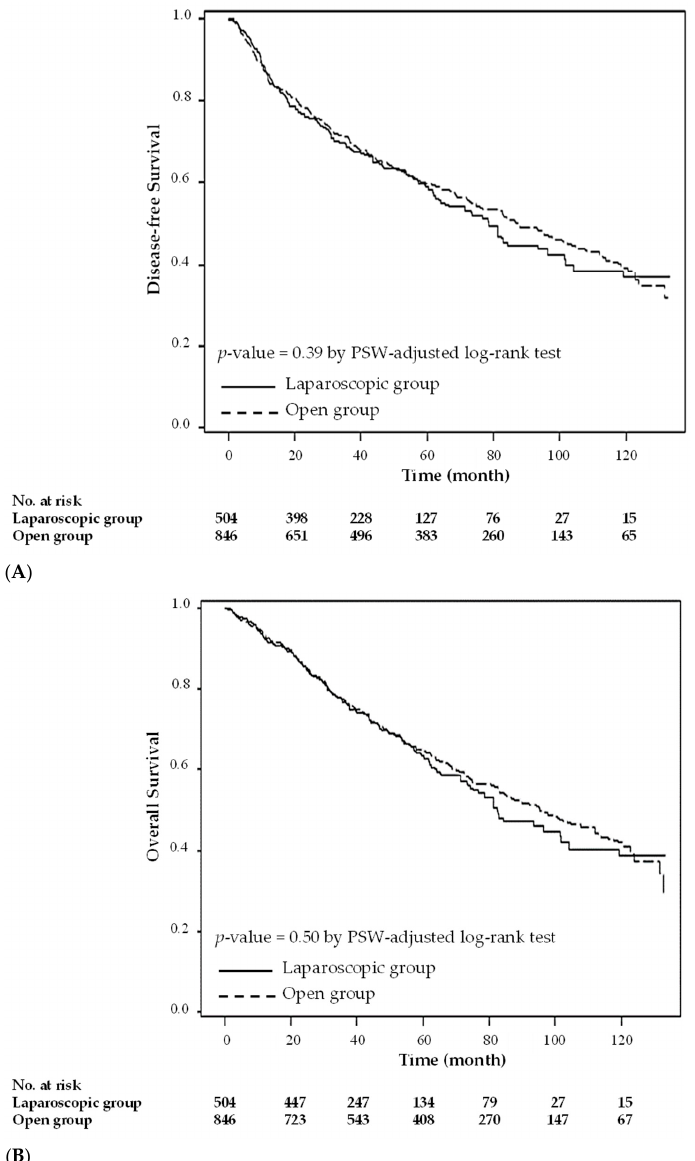
Figure 2. Overall survival and disease-free survival after propensity score weighting. ( A ). Disease- free survival; ( B ). Overall survival.